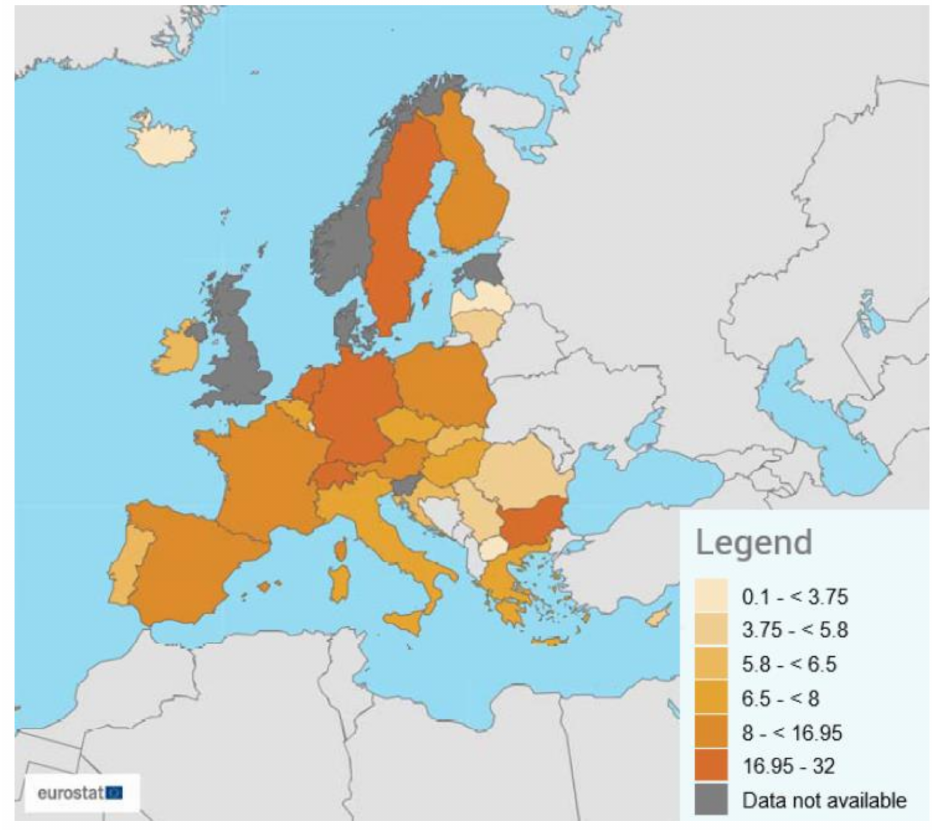
Figure 2. Parcels handled by all operators including courier, express and parcel services in